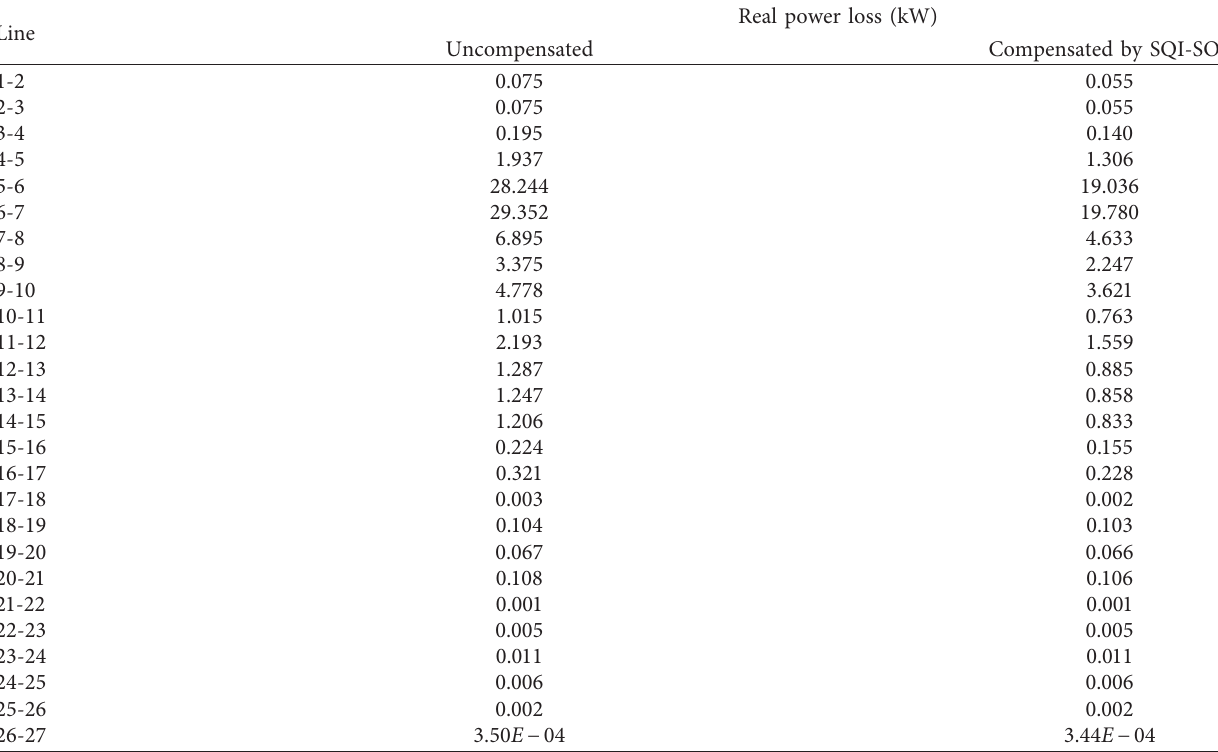
Table 10: Results of real power loss in all lines of the 69-bus system before and after the installation of capacitors.